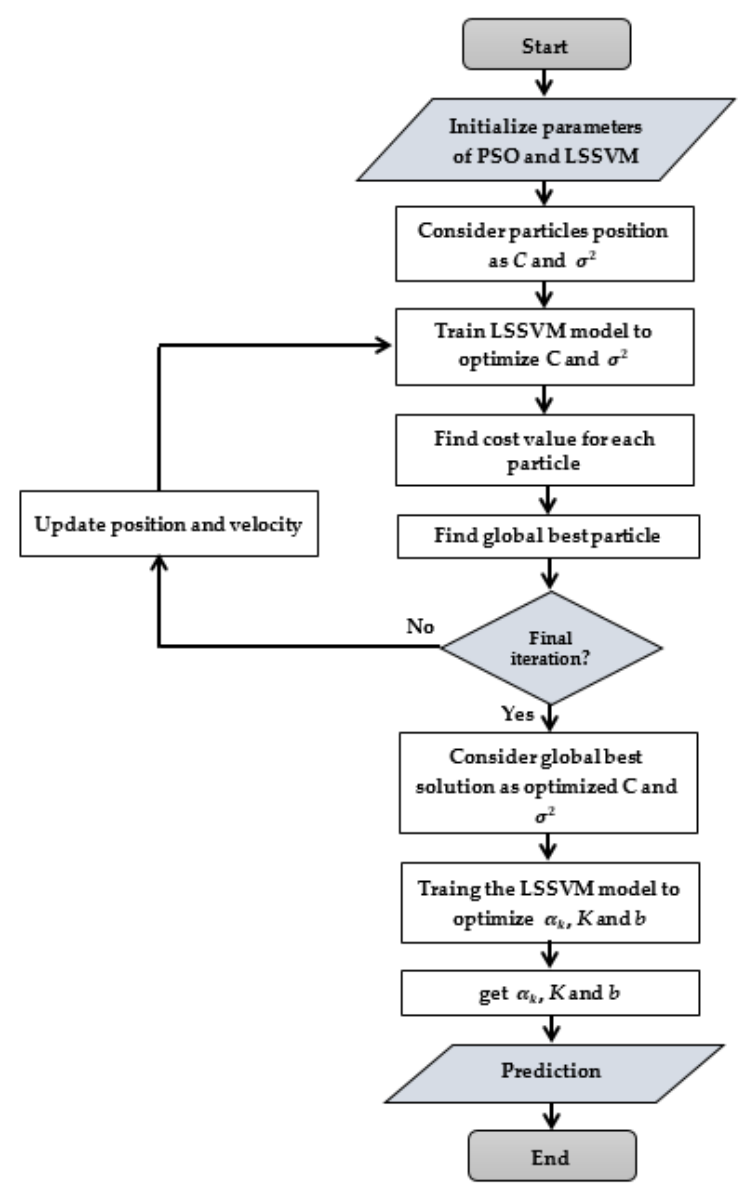
Figure 6. Flowchart of the PSO-LSSVM algorithm.